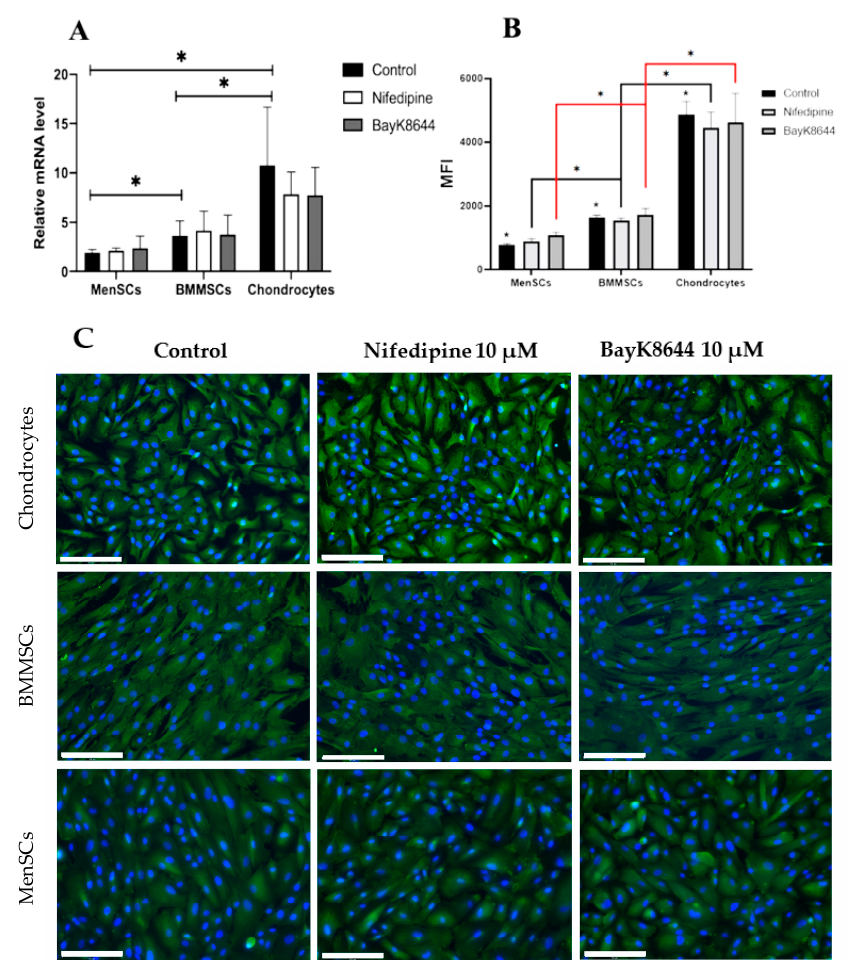
Figure 6. The effects of nifedipine and BayK8644 on CaV1.2 expressions in MenSCs, BMMSCs and chondrocytes. ( A ) The CACNA1C gene expression. Relative transcript level was evaluated comparing to the housekeeping B2M , RPS9 and ACTB genes and are significant at p ≤ 0.05. ( B ) CaV1.2 protein level measured by flow cytometer as mean fluorescence intensity (MFI); data are shown as mean of MFI ± standard deviation (SD). ( C ) Fluorescent micrographs of CaV1.2 in MenSCs, BMMSCs and chondrocytes after the stimulation with nifedipine (10 µ M) and BayK8644 (10 µ M) for the 3 days. Control–cells without any treatment. Cells were visualized with EVOs fluorescent microscope; the representative micrographs are shown; scale bar = 150 µ M. * Data are shown as mean ± standard deviation (SD) and are significant at p ≤ 0.05 ( n = 3) measuring three different donor sample-derived cells of each type using a two-way